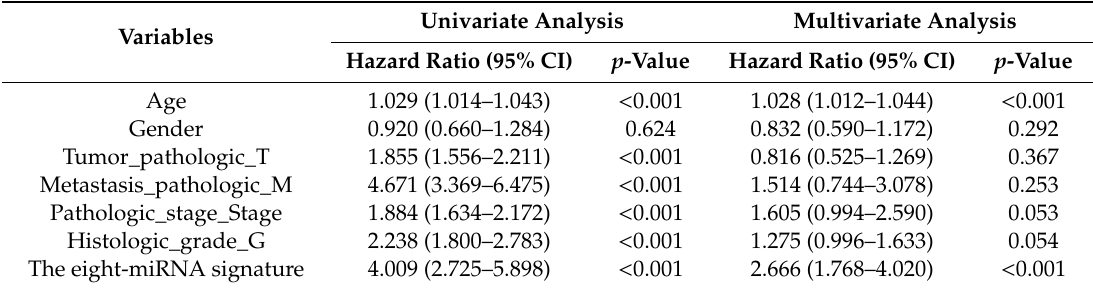
Table 1. Univariate and multivariate Cox regression analysis of the overall survival for clinical factors and risk of the combined eight prognostic miRNAs as a